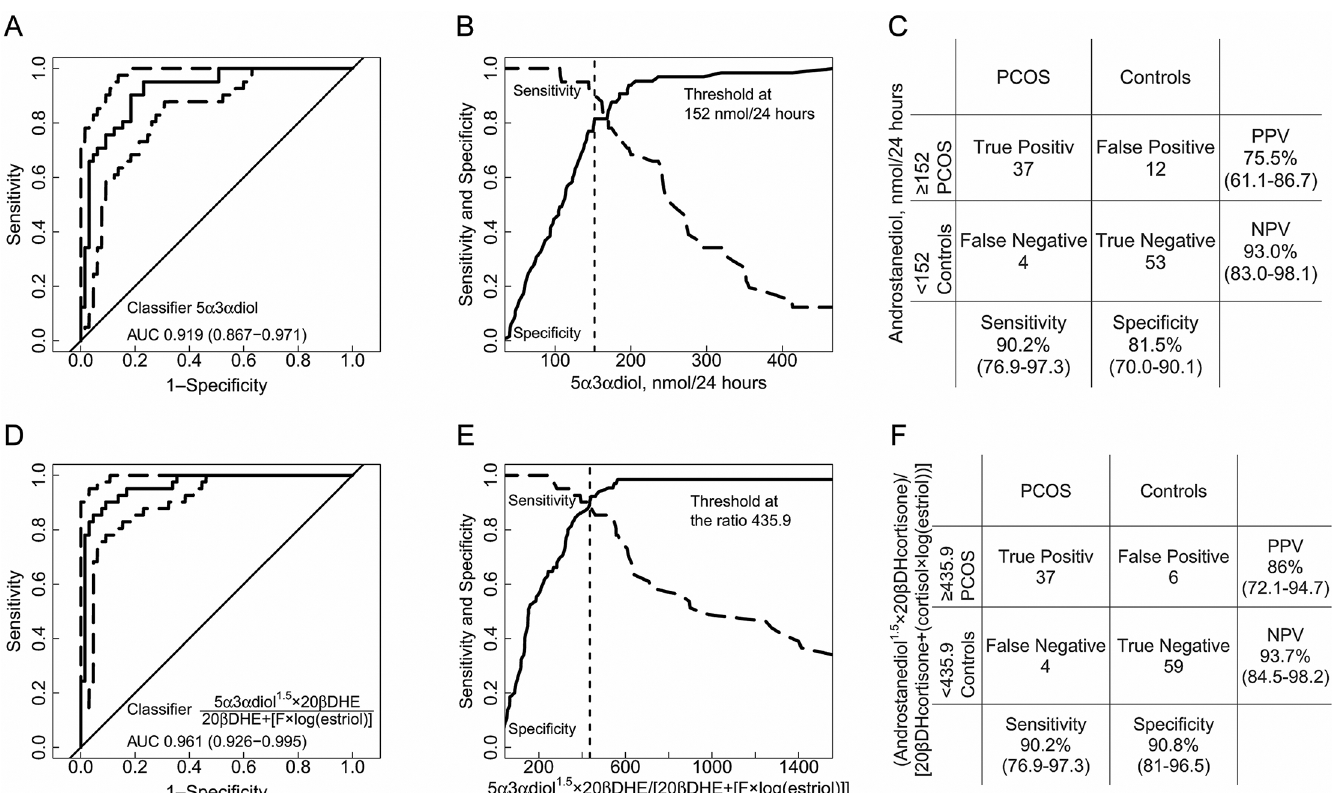
Fig 2. Diagnostic performance of urinary steroid metabolites in the prediction of PCOS. ROC curves for different classifiers of urinary steroid metabolites are shown on the left side, the corresponding plots of sensitivity-specificity versus the classifier are shown in the middle, and corresponding contingency tables on the right hand side. Dashed lines around the ROC curves indicate the 95% CI of the sensitivity at the given specificity. The AUC and its 95% CI is indicated. The dashed vertical lines in the sensitivity-specificity versus classifier plots indicate the threshold where sensitivity and specificity are simultaneously maximized. The main diagnostic performance parameters corresponding to this threshold are indicated. A-C. Classifier androstanediol. D-F. Classifier: (androstanediol 1.5 × 20 β -DH-cortisone)/(20 β -DH-cortisone +[cortisol × log(estriol)]) represents the best combination of 4 steroid metabolites. Abbreviations: 5 α 3 α diol: androstanediol, F: cortisol, 20 β DHE: 20 β -DH-cortisone, PPV: positive predictive value, NPV: negative predictive value, log: natural logarithm.